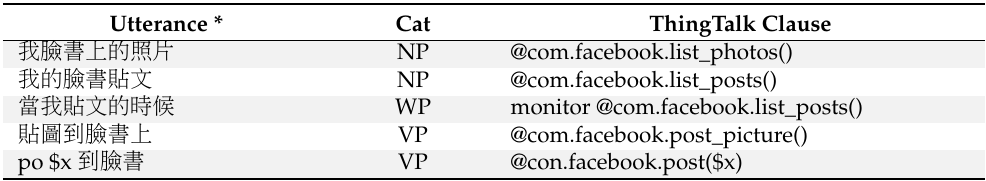
Table 4. Utterances in Chinese and their ThingTalk clause